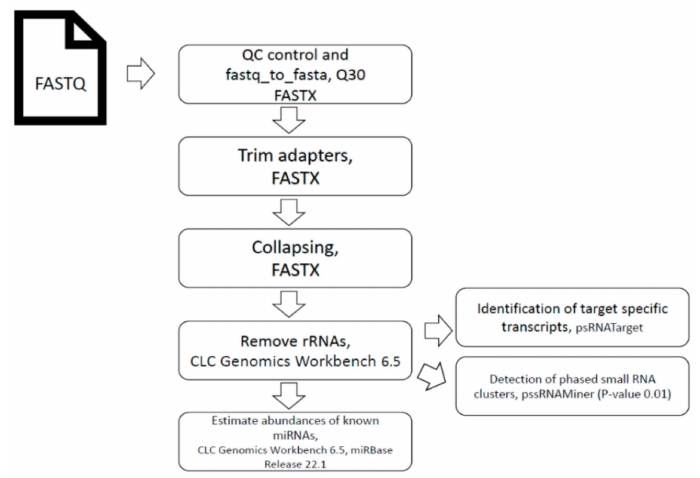
Figure 1. Flow chart of data